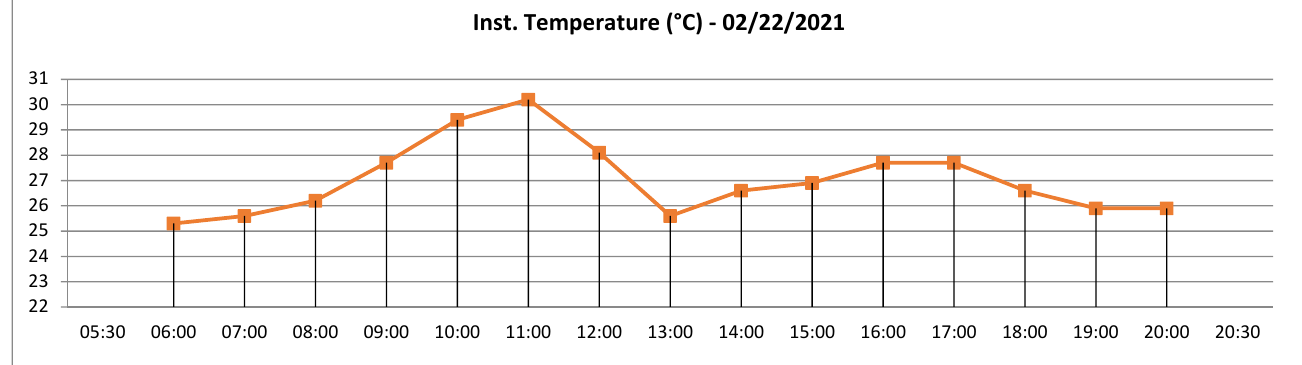
Figure 10. Rio de Janeiro—instantaneous temperature of the weather station at 02/22/2021. Considering that the instability at the regional level superseded microclimatic re- sponses, it was still possible to identify, on 14 February, 22 February, and 7 March, the formation of heat islands during the morning and night, up to moderate magnitude (2 °C to 4 °C) and in the afternoon, up to strong (4.1 °C to 6 °C) magnitude (Figure 11).